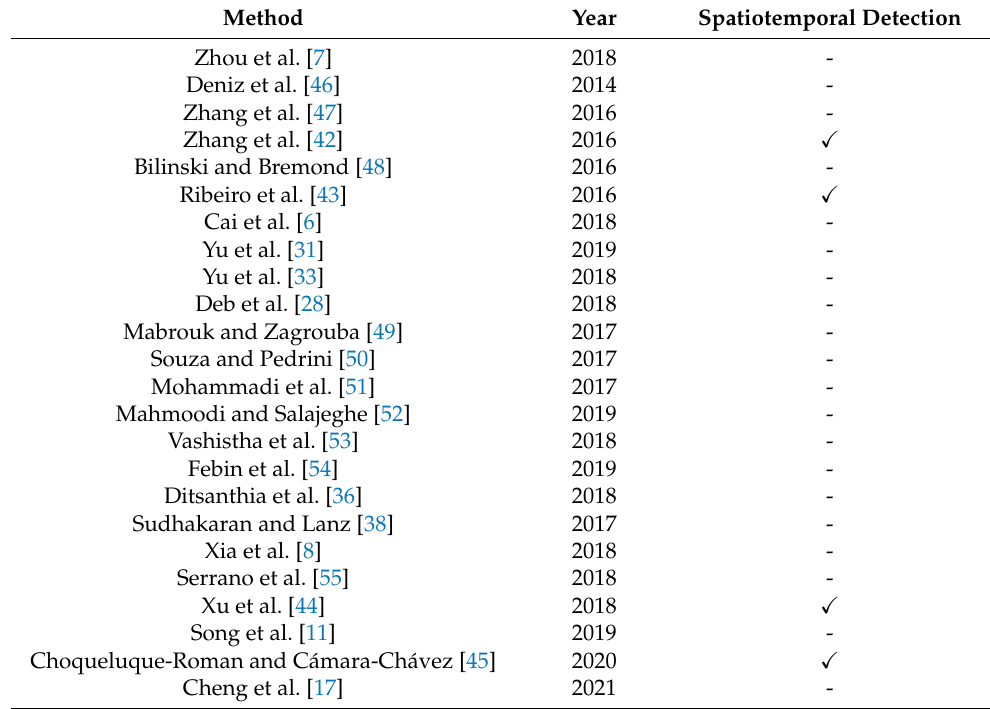
Table 1. Analysis of the literature of recent years with respect to spatiotemporal violence detection. Methods with a check detect violent actions both spatially and temporally. Methods with a hyphen only perform temporal